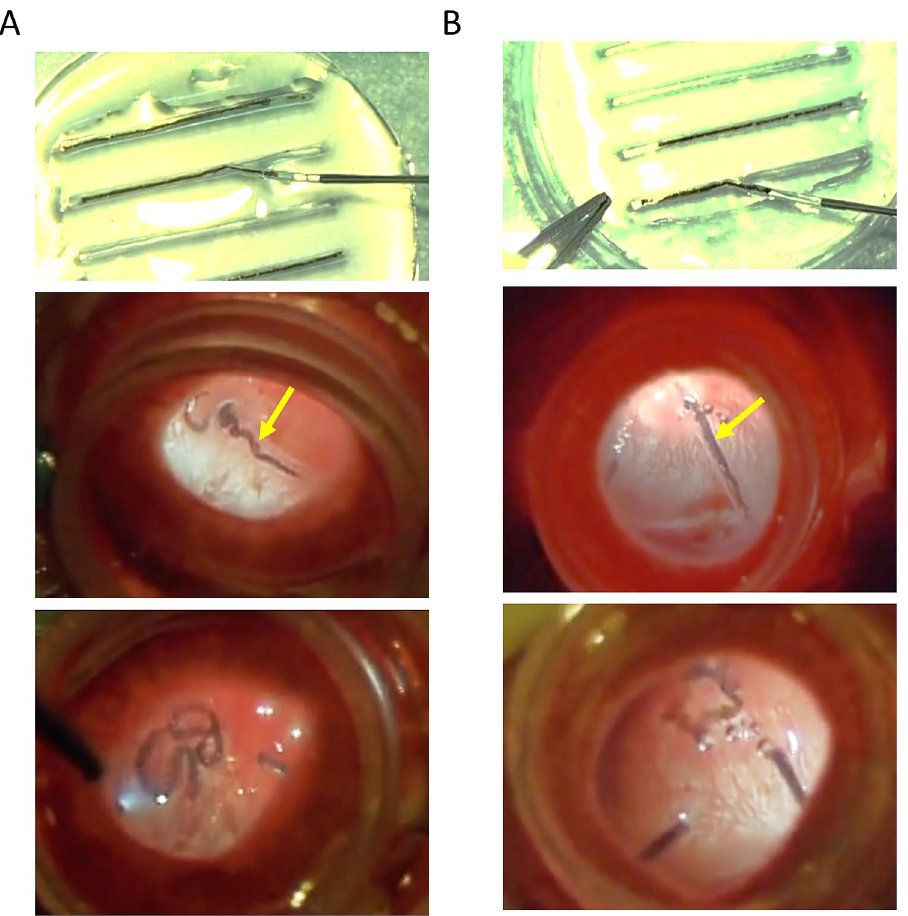
Figure 6. Procedure for transplantation of a hiPSC-RPE strip in two rabbit eyes. Practical handling of the hiPSC-RPE strip during the transplantation surgery was tested in two rabbit eyes (A,B) . Top: Loading of the hiPSC-RPE- strip. Middle: An hiPSC-RPE-strip was slowly injected into the retinal bleb. The retinal incision site is marked by a yellow arrow. Bottom: Injected hiPSC-RPE-strip. Some the surgical steps are provided as a Supplemental Movie for B.